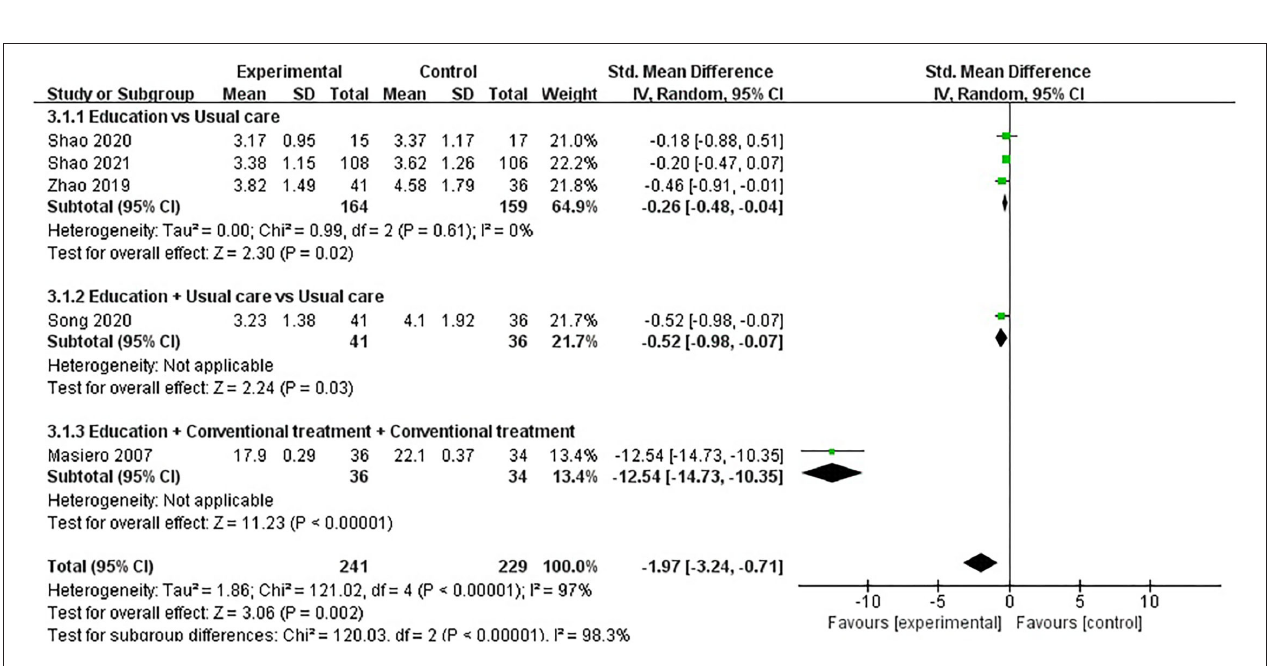
FIGURE 5 | Meta-analysis on Disease